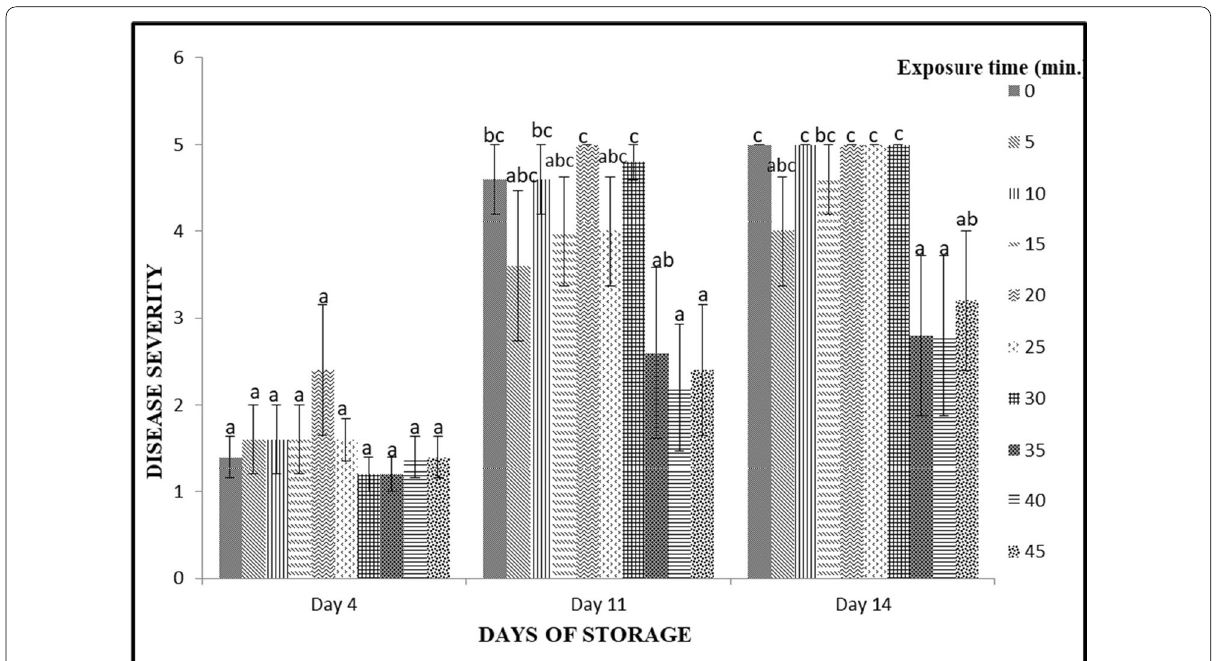
Fig. 1 Effect of exposure to gasoline fuel emission on severity of rot caused by Rhizopus stolonifer on ripe tomato